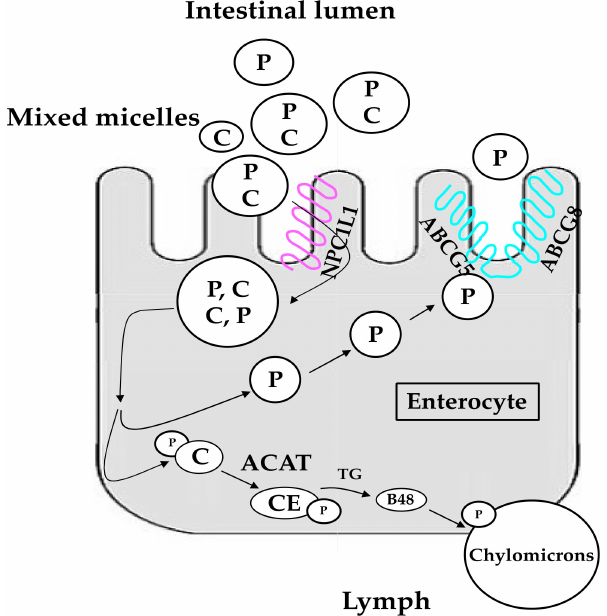
Figure 1. Main metabolic pathways of cholesterol and phytosterol in enterocytes. P, phytosterols.; C, cholesterol; CE, cholesteryl esters; ACAT, acylCoA cholesterol acyltransferase; NPC1L1, Niemann- Pick C1-Like 1; ABCG5, ATP-binding cassette G5; ABCG8, ATP-binding cassette G8; TG, triglycerides; B48, Apolipoprotein B-48. Modified from [18] and